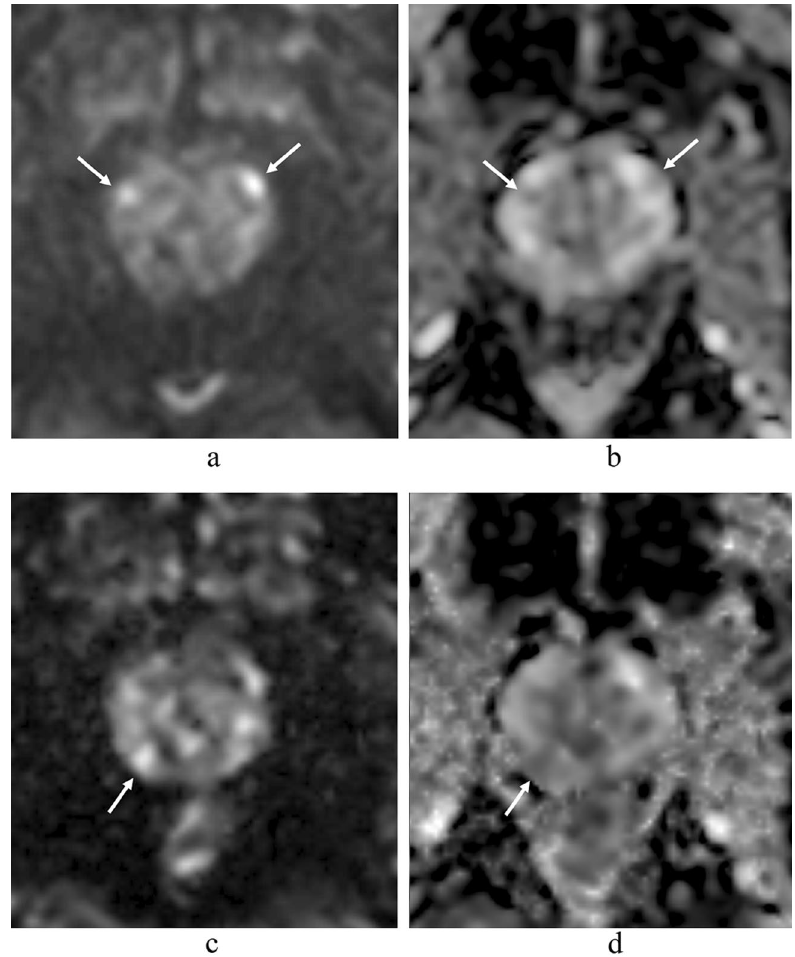
Figure 5. A 77-year-old man with prostate cancer (prostate-specific antigen level, 5.10 ng/mL; Gleason score, 4 + 3) in the apex of the left peripheral zone and the left transition zone (not shown). SsEPI DWI ( a ) and ADC map in ssEPI DWI ( b ) show lesions corresponding to a DWI/ADC map score of 3 on the anterior middle regions of the bilateral peripheral zones (arrows). However, the same regions were diagnosed with a DWI/ADC map score of 1 in msEPI DWI ( c ) and ADC map in msEPI DWI ( d ). MsEPI DWI ( c ) and ADC map in msEPI DWI ( d ) show a lesion corresponding to a DWI/ADC map score of 2 in the posterior middle region of the right peripheral zone (arrow). Prostatectomy specimens confirmed a diagnosis of benign prostatic condition for the three middle regions in the right and left peripheral zones. Thus, for the bilateral middle peripheral zone lesions, ssEPI DWI gave a false-positive result and msEPI DWI showed a true-negative result. PSA prostate-specific antigen, ssEPI single-shot echo-planar imaging, DWI diffusion-weighted imaging, ADC apparent diffusion coefficient, ssEPI single-shot echo-planar